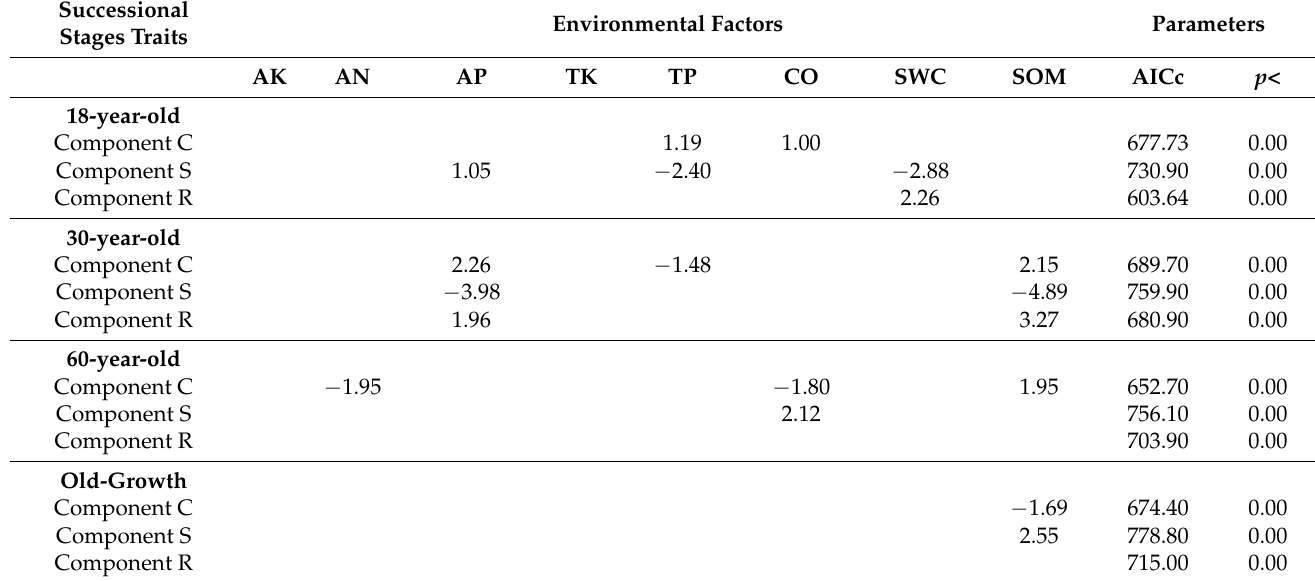
Table 2. Linear mixed-effects models analysis between species-level plant ecological strategy values and environmental factors in the different successional forests. (Available potassium (AK, mg kg − 1 ), available nitrogen (AN, mg kg − 1 ), soil available phosphorus (AP, mg kg − 1 ), total